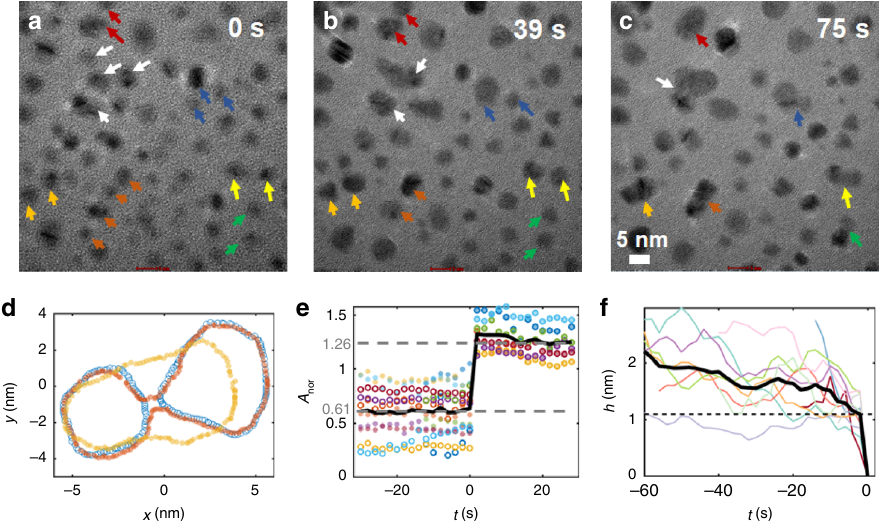
Fig. 3 LP-TEM data of ZnO nanoparticle diffusion and coalescence in methanol containing 1 mM Zn 2 + . a – c Time sequence of images, particles marked by the same colors eventually coalesce. d Particle contour of two merging particles. Blue to red to yellow markers denote early to late frames. e Normalized particle area versus time during the attachment process. Filled and open markers denote individual particles in a particle pair while colors designate distinct particle pairs. The gray dotted lines denote the average particle size prior to and after attachment. f Edge-to-edge separation of pairs of approaching particles showing jump to contact. Colors designate distinct particle pairs.